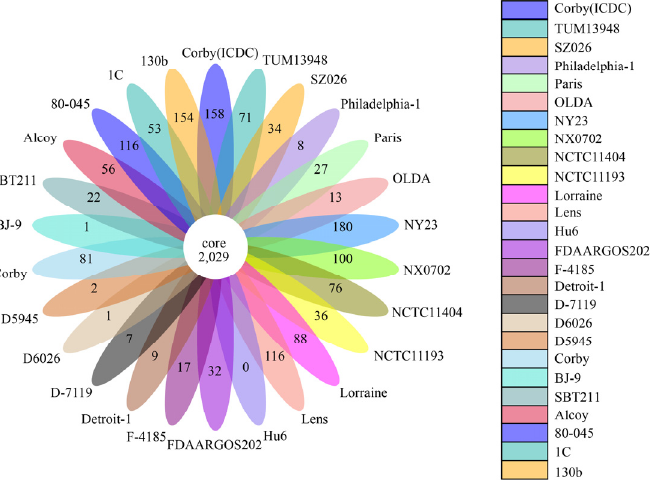
Figure 3. Core and specific genes of 26 genomes of serogroup 1 Legionella pneumophila . Each petal represents a strain genome. The number in the centre of the graph represents the core genes shared among the 26 strains. Numbers on each petal represent the genes specific for each strain.